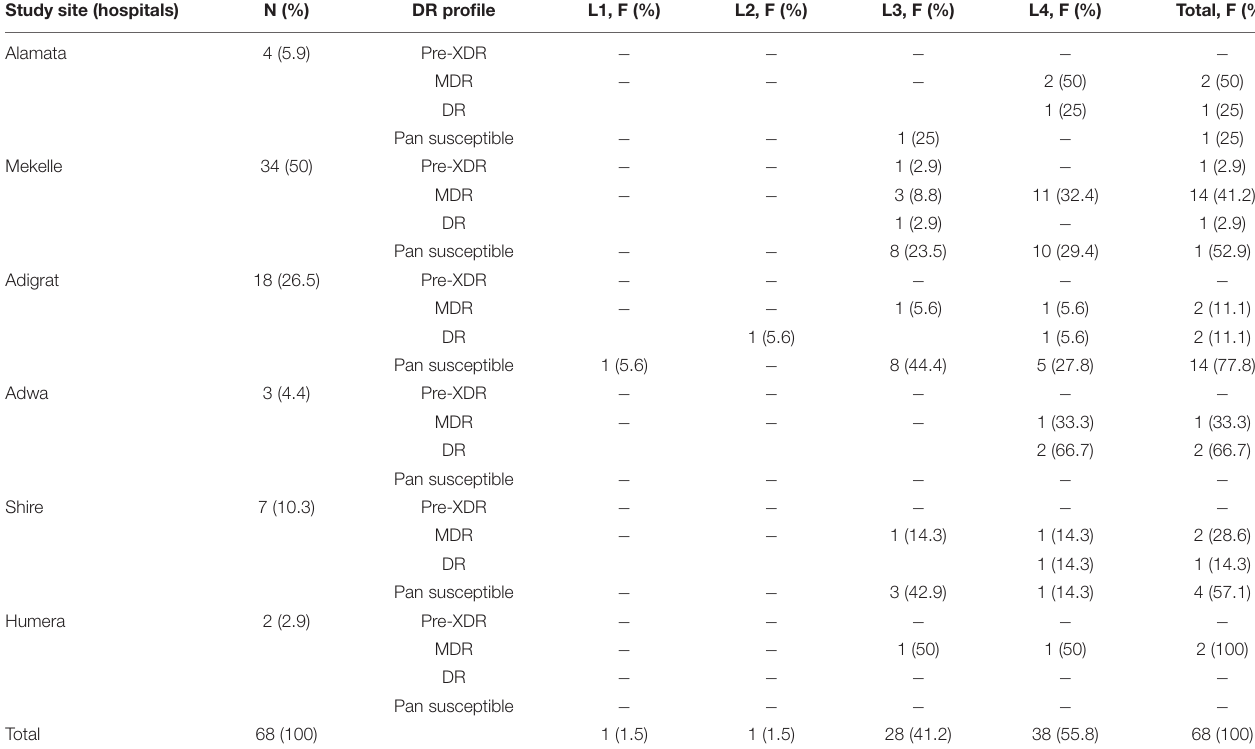
TABLE 2 | Distribution of Mycobacterium tuberculosis strains isolated from PTB patients, Tigray Region Ethiopia, July 2018–August 2019. Study site (hospitals)